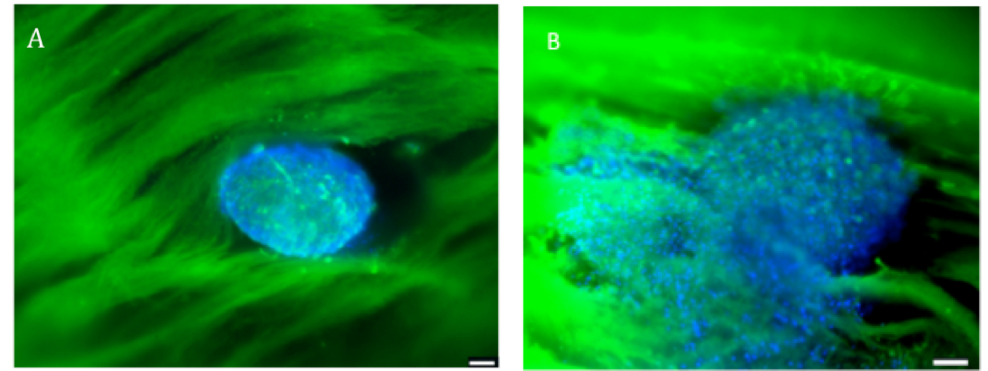
Figure 2. Fluorescence confocal microscopy visualization of human primary osteoblasts microtissues seeded onto the scaffold, and stained with DAPI (showing DNA) and PLL ‐ FITC (showing the nanofibers). ( A ) Microtissue nesting in the scaffold at day 0; ( B ) Microtissue at day 3 of in vitro culture in the scaffold. Scale bar = 100 μ m. n = 3.